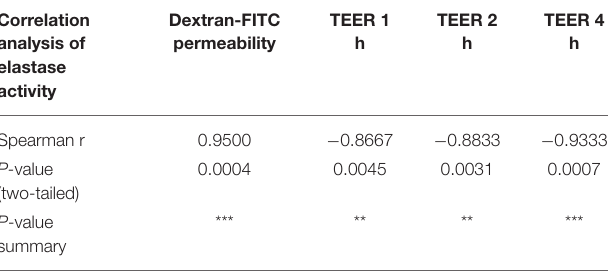
TABLE 1 | Spearman correlation analysis of elastase activity with Dextran-FITC permeability and TEER at different time-points. Correlation analysis of elastase